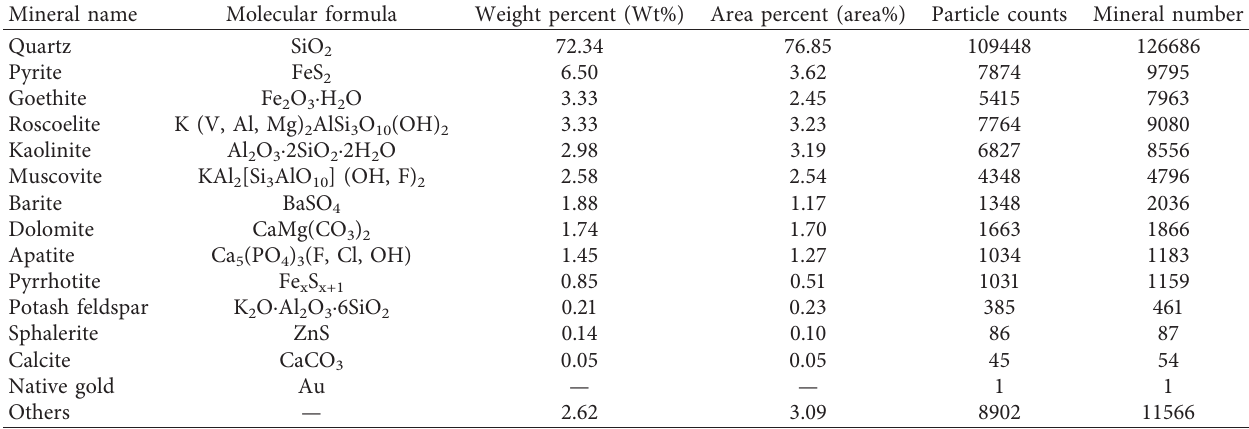
Table 2: Mineral compositions of the sample.